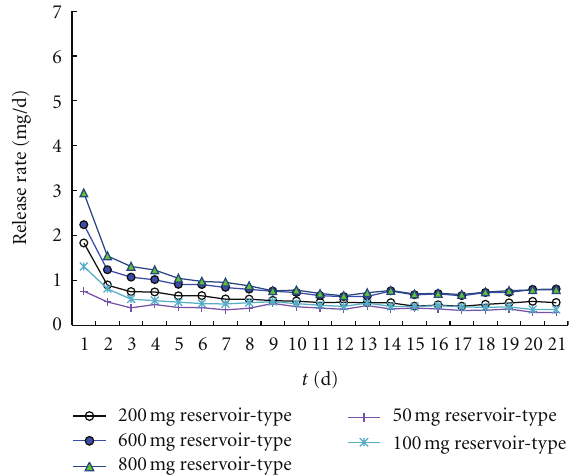
F 8: e in�uence of the content of drug on the release pro�le of drospirenone reservoir-type IVR.